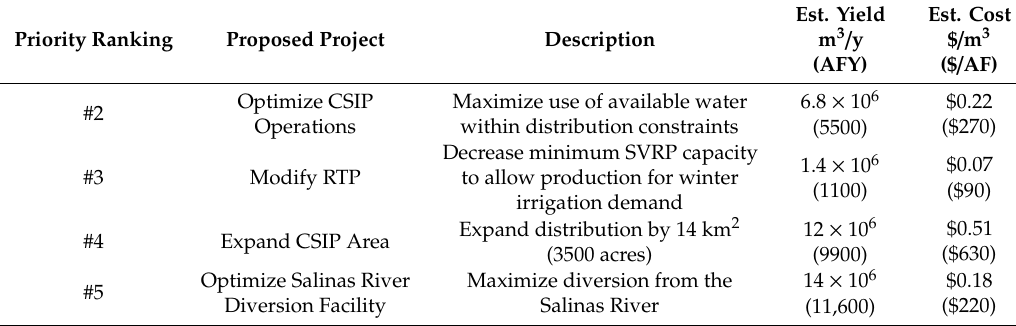
Table 1. Salinas Valley Basin Groundwater Sustainability Agency ranked priority projects for improving the Castroville Seawater Intrusion Project, CSIP (data from